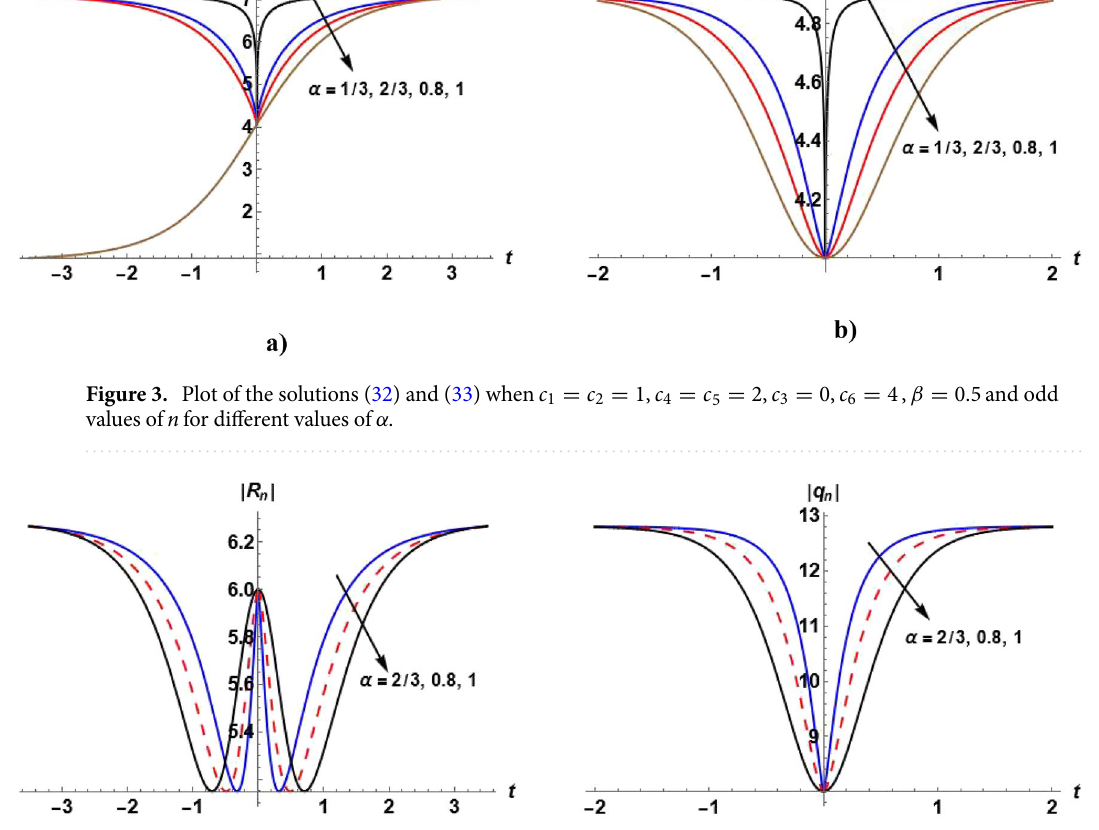
c c c 2, c 2 5, c 4 3 = 6 = 0 , β = 0.5 and odd 5 = 4, = − = =